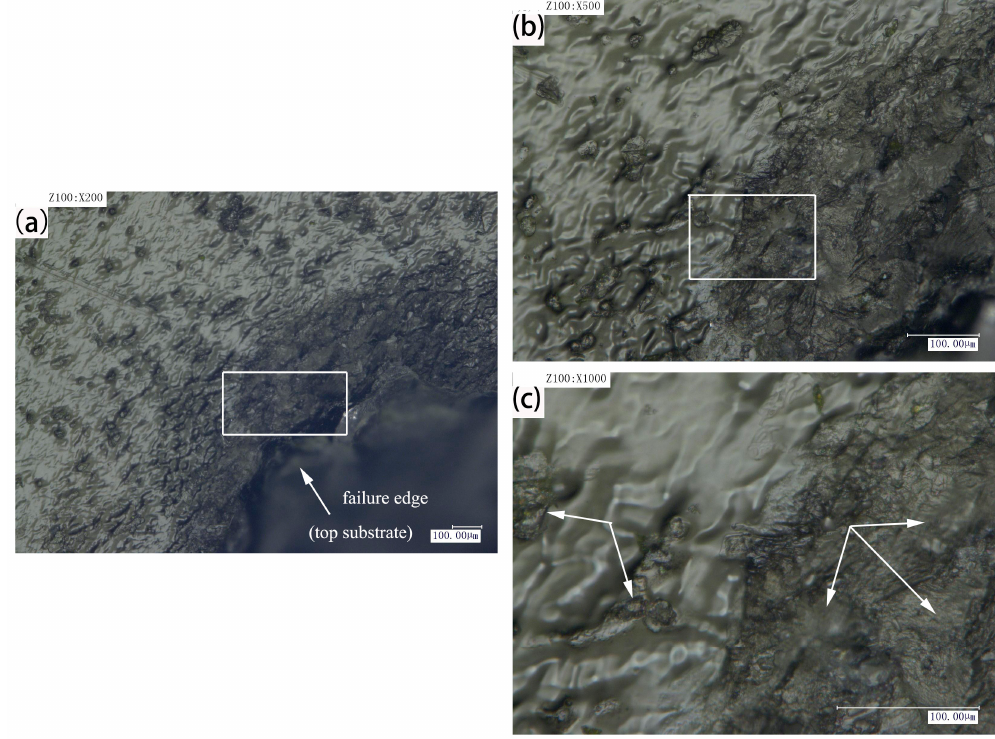
Figure 6. Post-failure images of the bond interface for the samples (type I, 480 V, 6 mm),